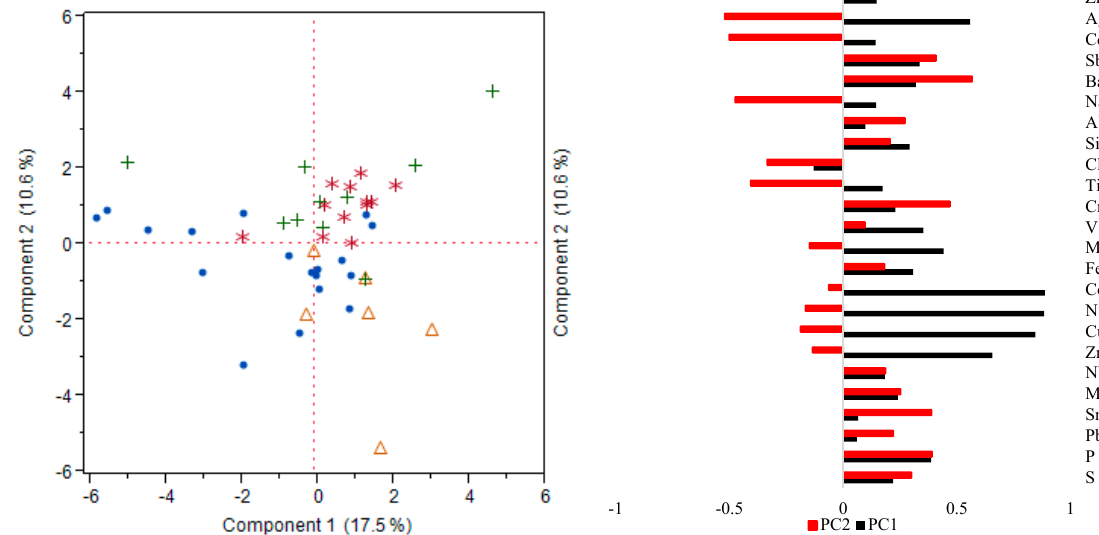
Figure 2. Principal component analysis of the elemental analysis of oils derived from different sources and olive oils of different geographical origin. Red stars (*) represent the olive oils derived from indigenous cultivars; green crosses (+) represent locally derived foreign olive oils; blue dots (•) represent foreign olive oils; and orange triangles ( ∆ ) represent oils derived from other seed oils. (Right) Eigenvector loading scores for each element for the first two principal components.